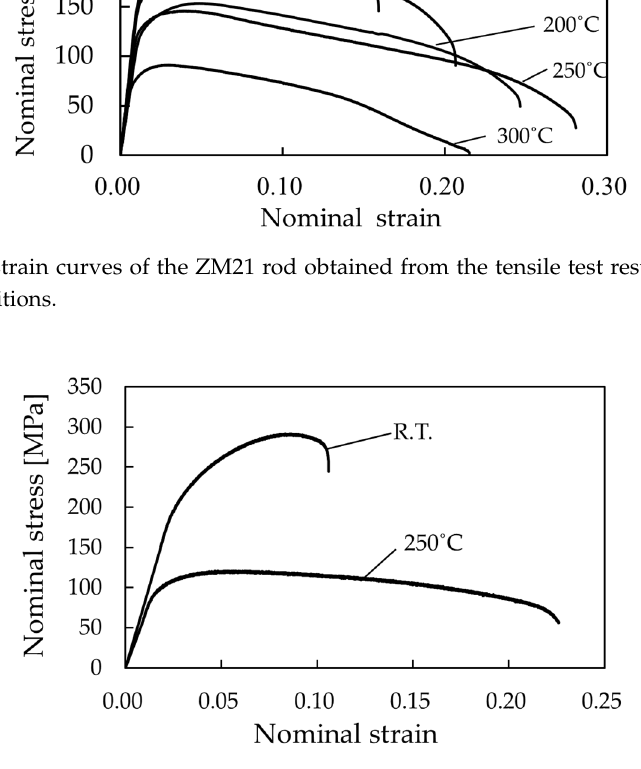
Figure 5. Stress–strain curves of the small-diameter ZM21 tube obtained from the tensile test result at R.T and 250 °C.